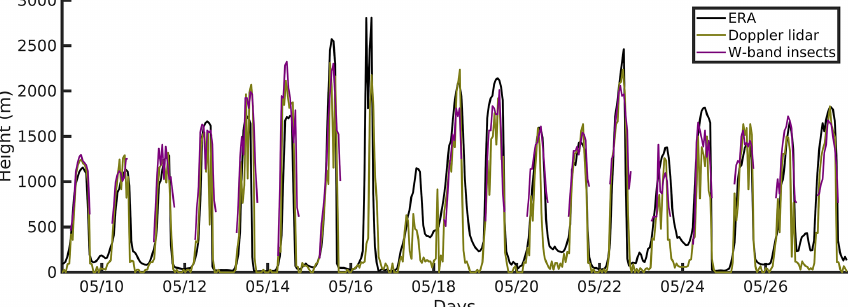
Figure 10. Time series of the CBLH during May 2018 derived using insects from the W-band radar compared to the HALO Doppler lidar retrievals and ERA5.